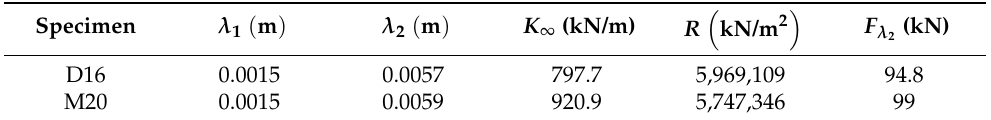
Table 8. Parameter identification results of the specimens.